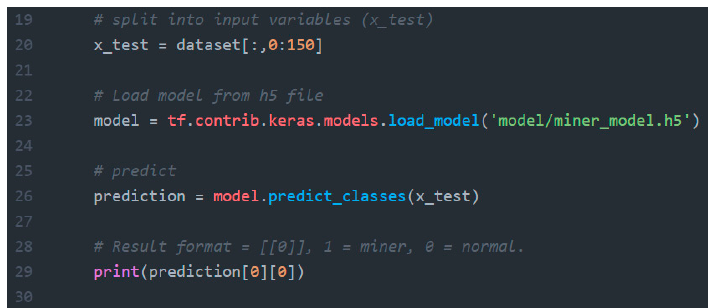
Figure 11. Identify whether the website is embedded mining code or not.